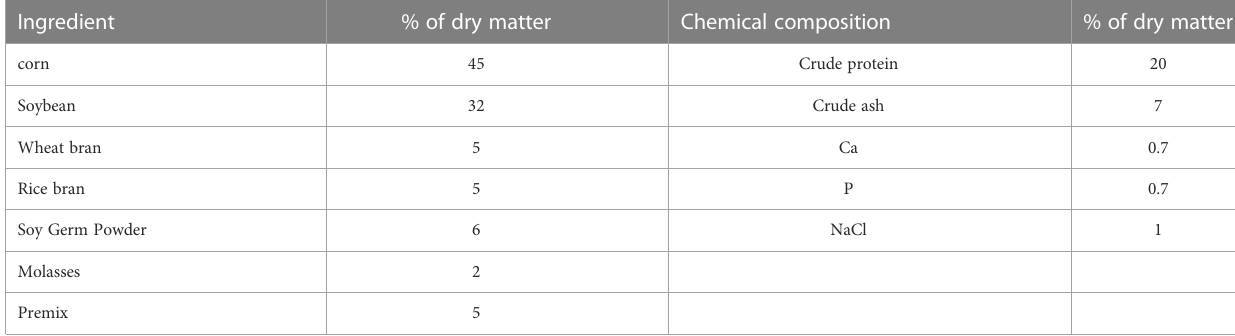
TABLE 1 Ingredients and chemical composition of